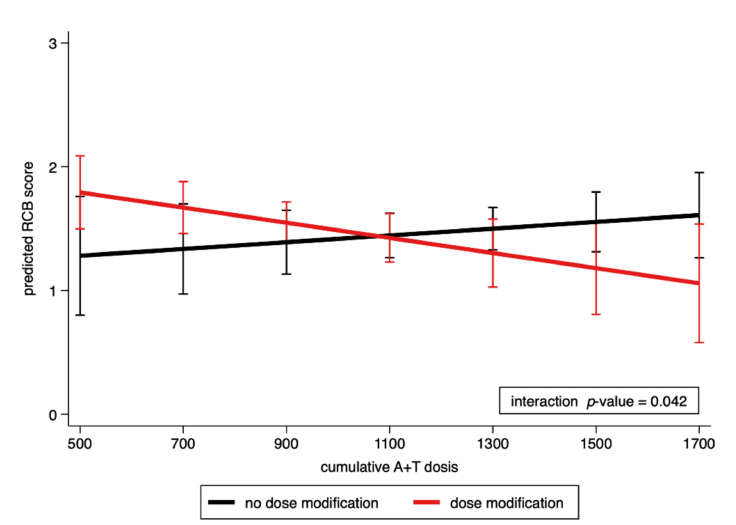
Figure 4. Interaction of cumulative A + T doses by dose reduction. Lower doses of cumulative neoadjuvant A/T are associated with higher RCB scores in patients who required a dose